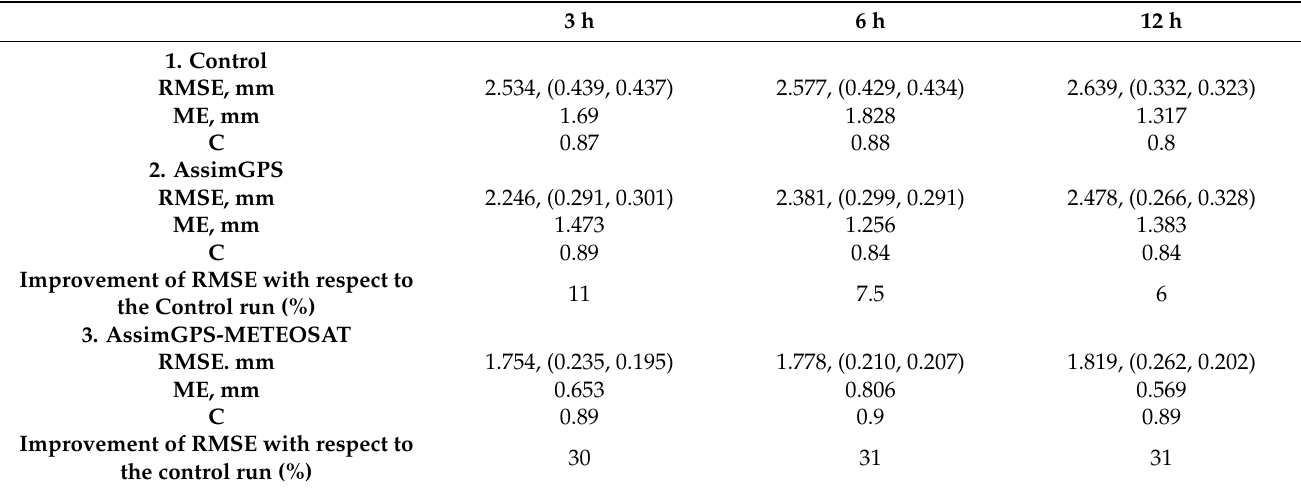
Table 2. ME and root mean square error (RMSE) values for first guess, analysis, and GPS 2D maps in comparison to radiosonde values.